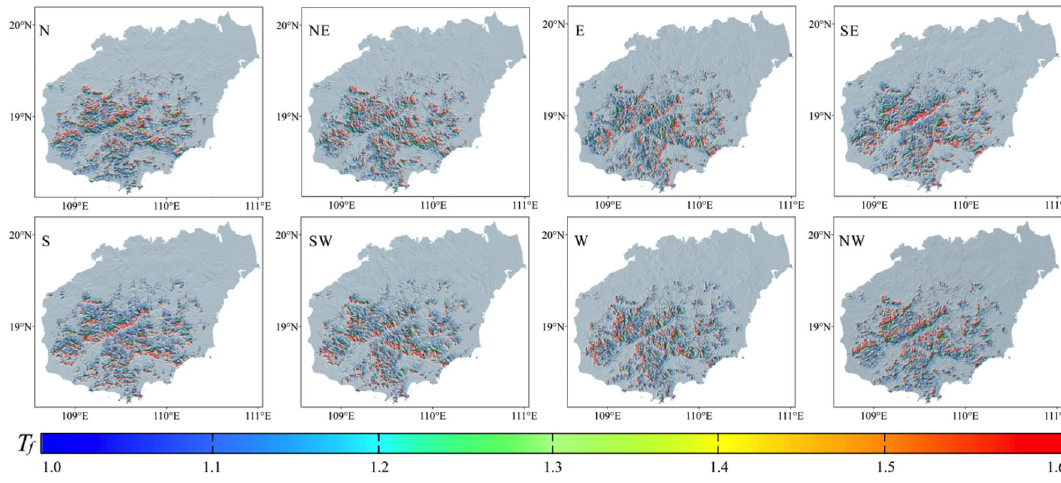
Fig. 4 Terrain speed-up factors for Hainan Island, China, for eight wind